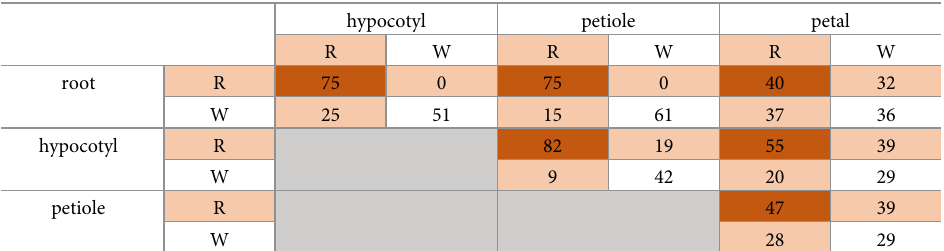
Table 4. Relationships among tissue